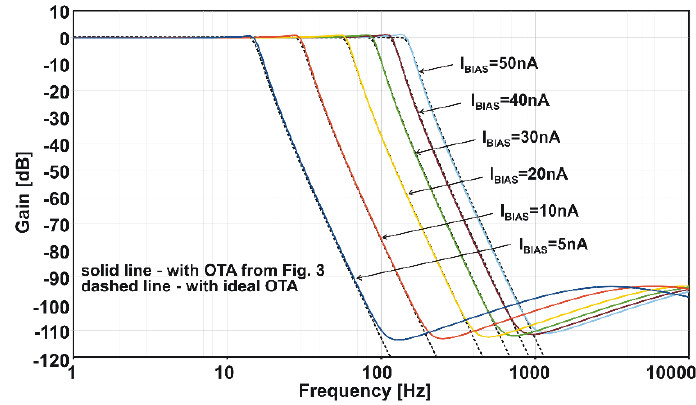
Figure 12. Simulated amplitude responses of the filter from Figure 8.